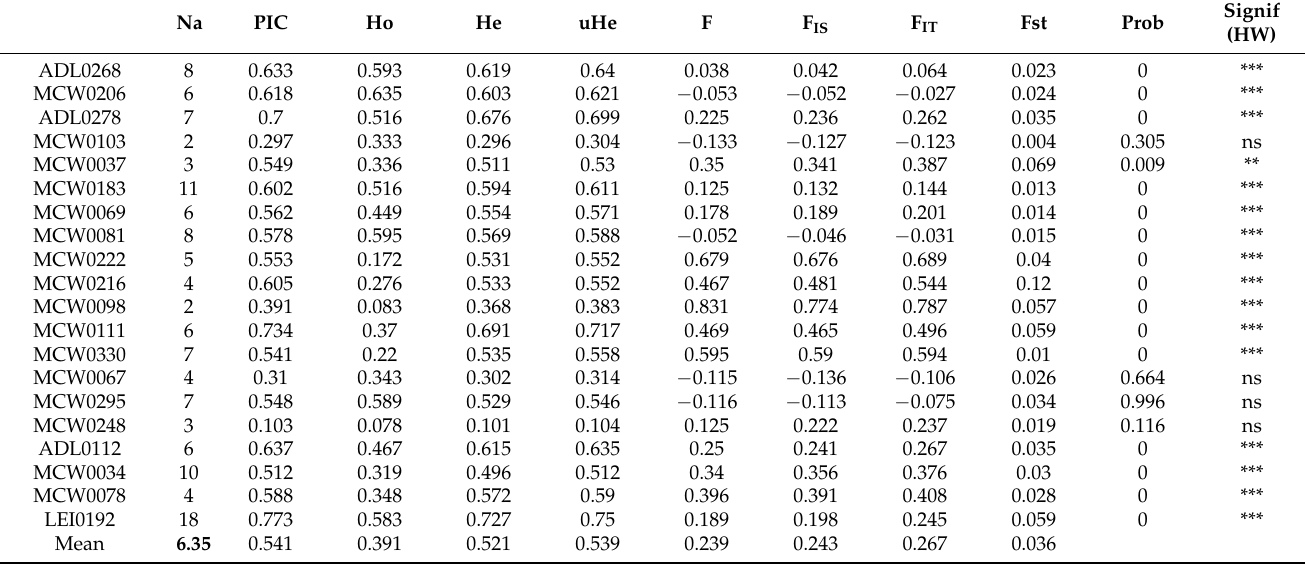
Table 1. Number of alleles (Na), polymorphism information content (PIC), observed (Ho) and expected (He) and unbiased (uHe) heterozygosity, fixation index (F), Wright’s F-statistics (F IS , F IT and F ST ) and Hardy Weinberg (HW) tests.